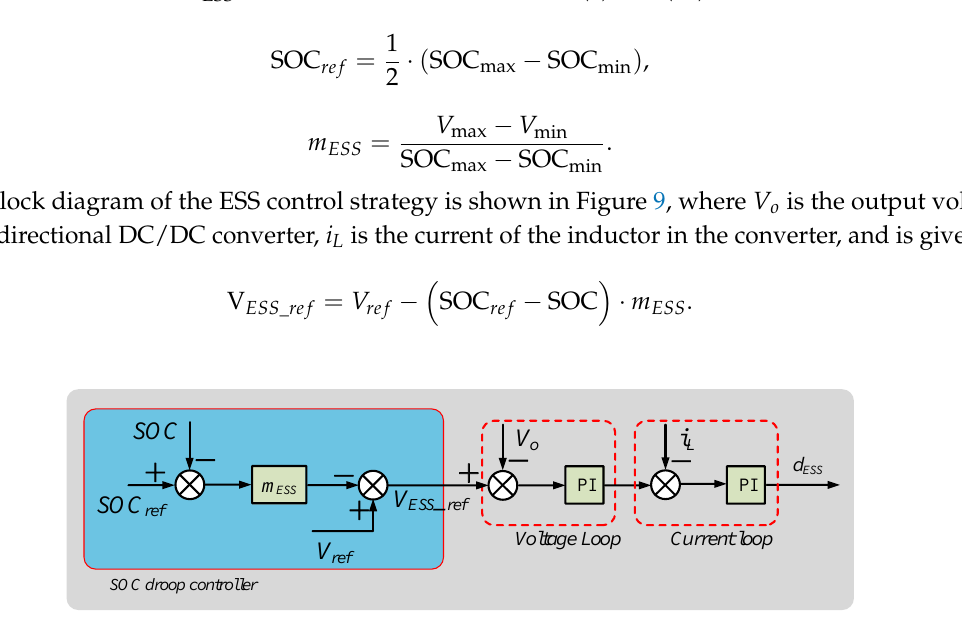
Table 1. Parameters of the PV modules and ESS used in simulation.